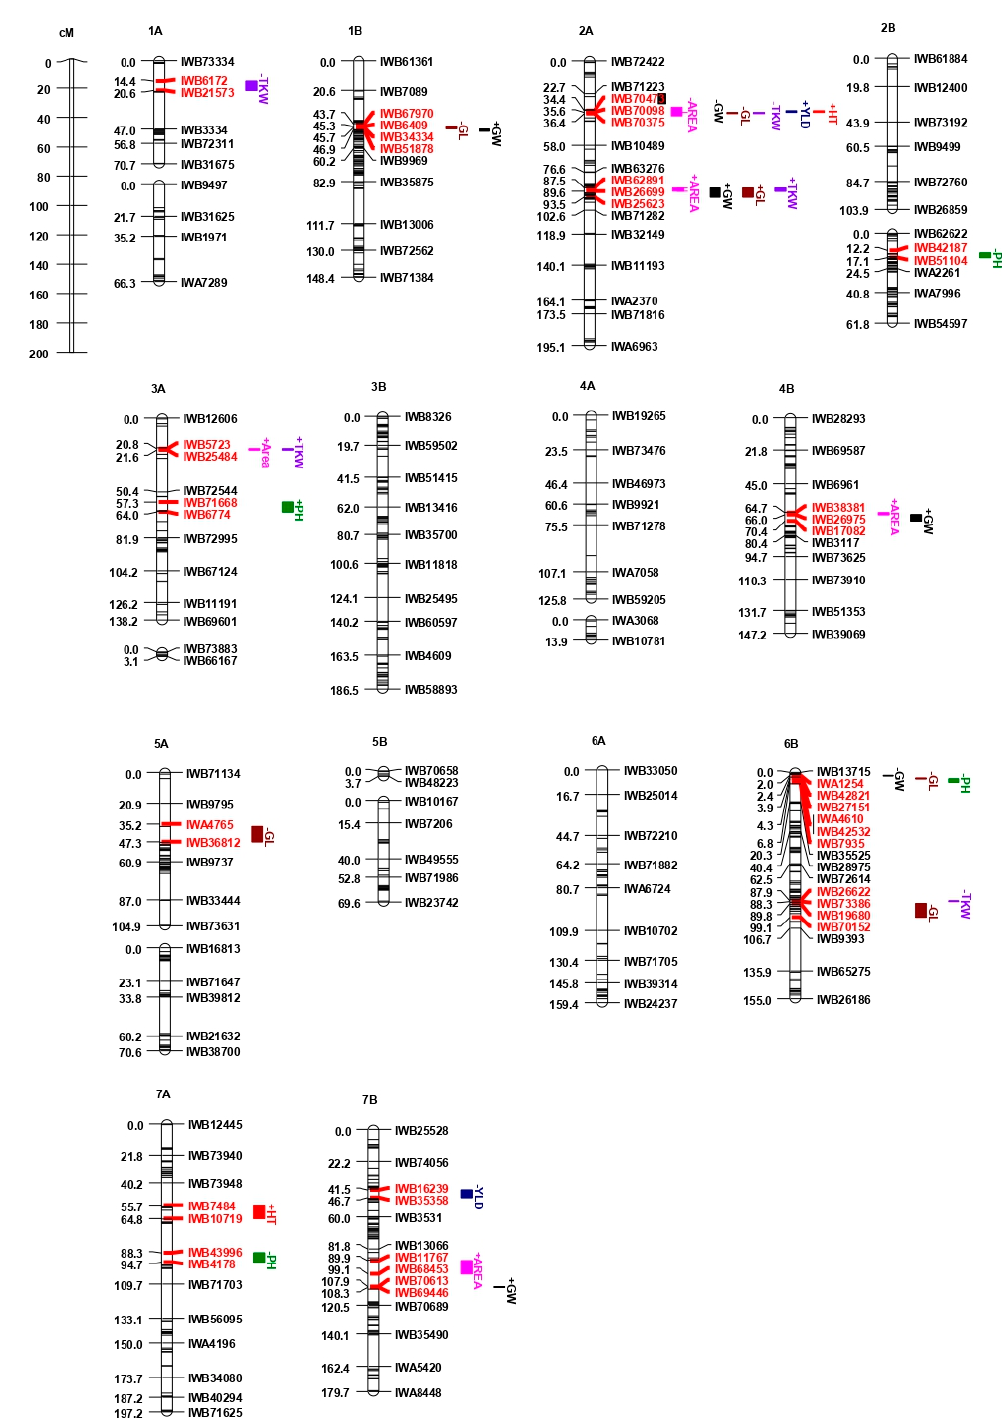
Figure 2. Schematic representation of the durum linkage map Liberdur x Anco Marzio with map positions of QTL for grain yield (YLD), plant height (PH), heading time (HT), thousand kernel weight (TKW), grain length (GL), grain width (GW), grain area (AREA). Each chromosome map is represented by the first and the last SNP marker, and by a SNP marker every about 20 cM. Markers are indicated on the right side and cM distances on the left side of the bar. QTL are represented by bars on the right of each chromosome bar. The + or − preceding the QTL name indicate the positive or negative additive effect of the parental line Liberdur. The left and right SNP markers of the QTL interval are indicated in red.